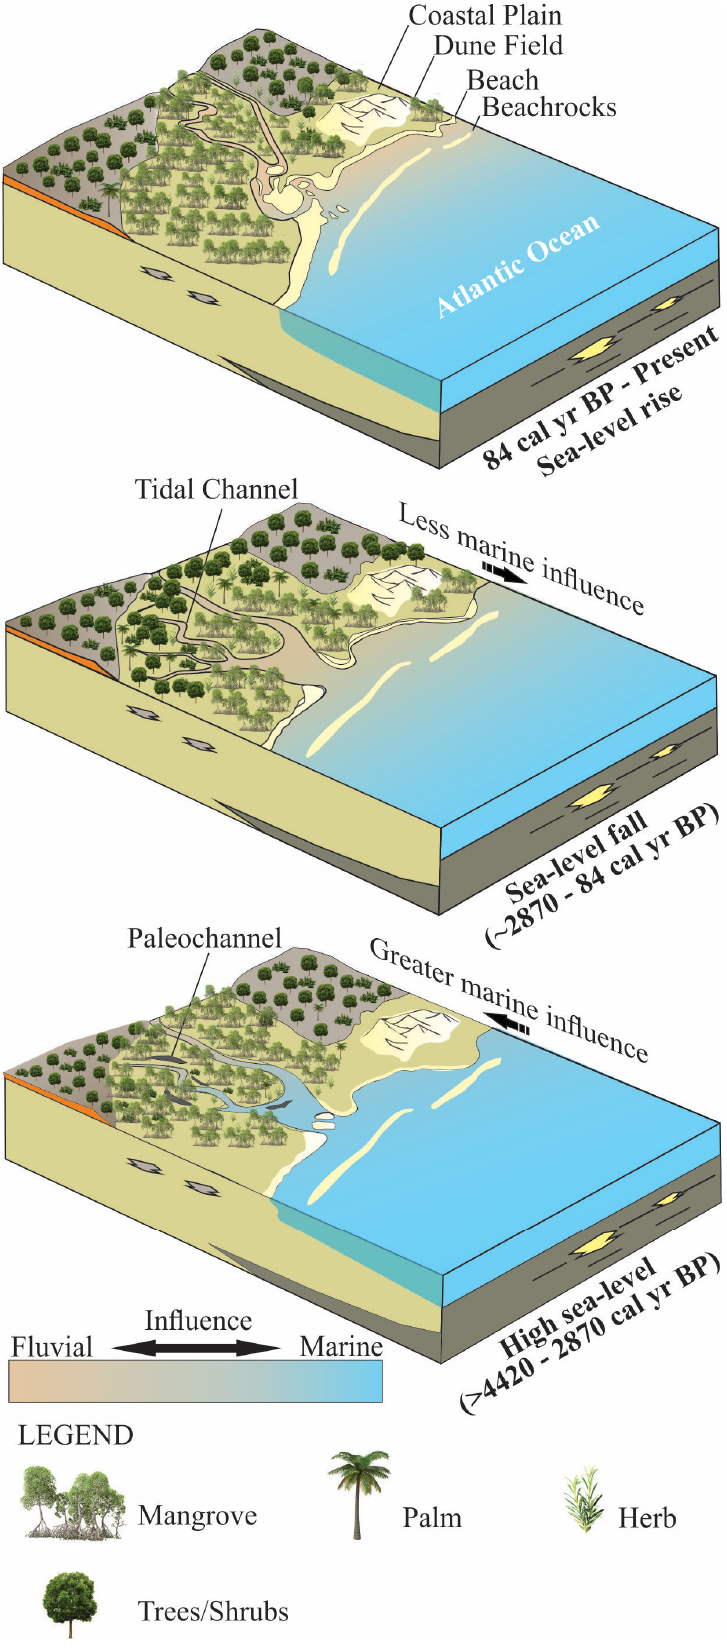
Figure 9. Eco – geomorphological models according to sea – level fall during the mid – late Holocene. Figure 9. Eco–geomorphological models according to sea–level fall during the mid–late